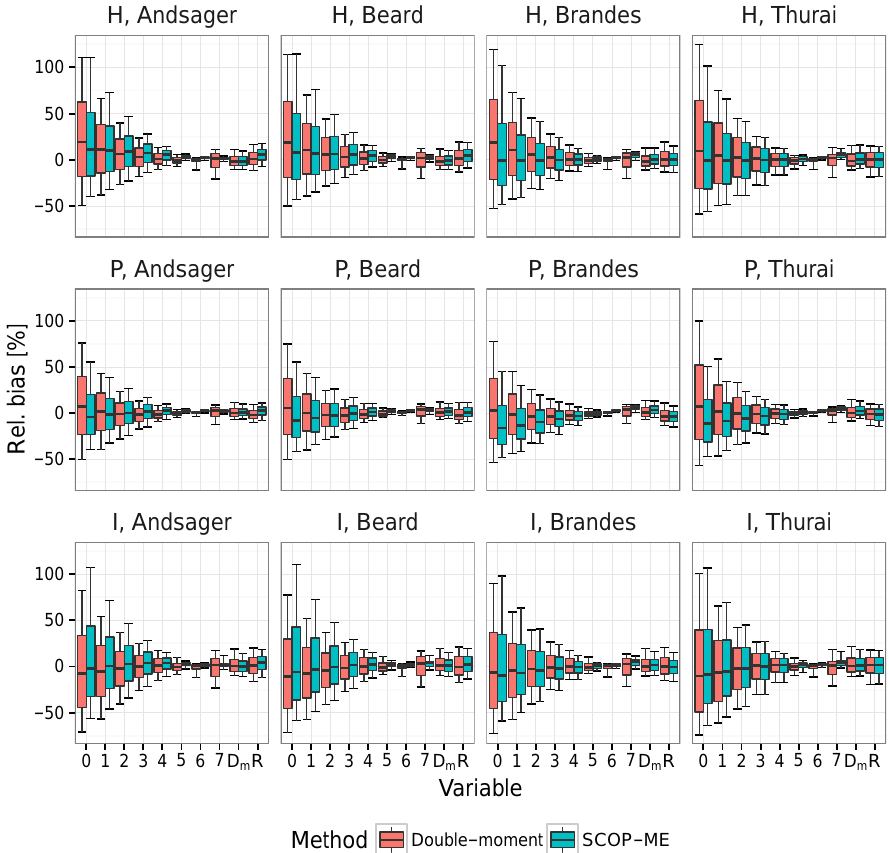
Figure 2. Relative bias distributions for the double-moment and SCOP-ME DSD-retrieval methods, by drop axis ratio function and data set (H stands for HyMeX, P for Payerne, and I for Iowa). Variables are moment order n (mm n m − 3 ), D m (mm), and R (mmh − 1 ). Bold bars show medians, boxes show IQRs, and whiskers show 10th to 90th percentile